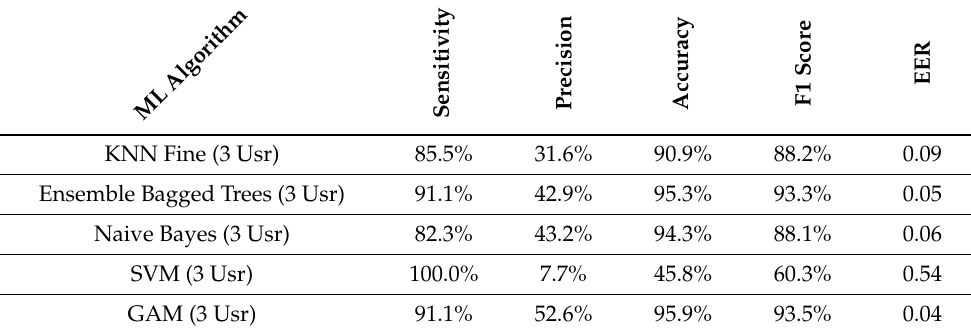
Table 5. ECG Result Details—Multiuser Authentication.